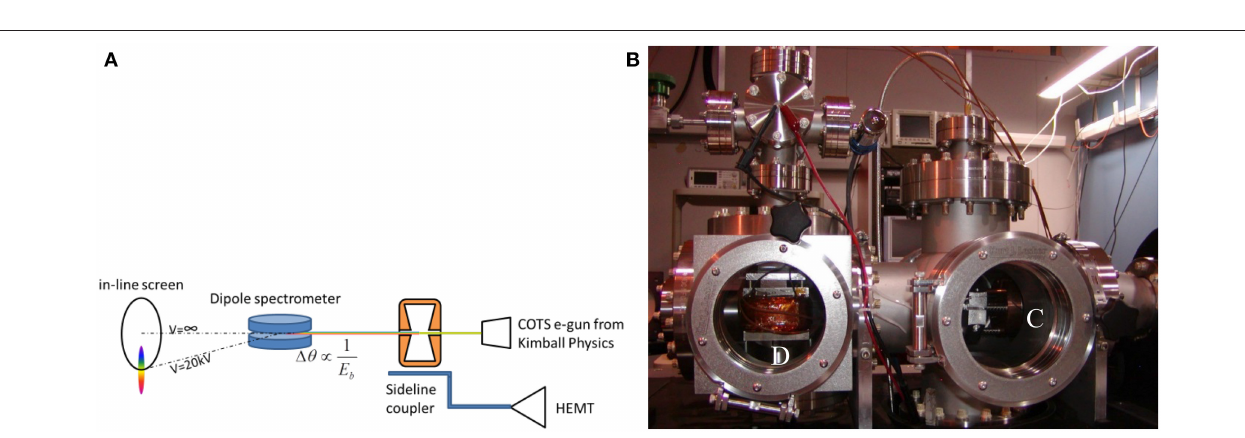
FIGURE 11 | (A) Schematic of the single-cavity energy gain measurement. The deflection angle is inversely proportional to the momentum of the electron beam; (B) Photo of the single-cavity energy gain measurement with the cavity (labeled C) mounted immediately after the Kimball-Physics electron gun (to the right of this picture), and the dipole spectrometer (labeled